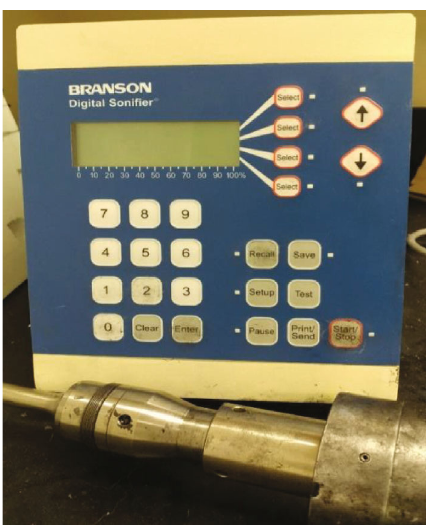
Figure 1: Ultrasonicator equipment which has been used to mix the CNTs with epoxy.